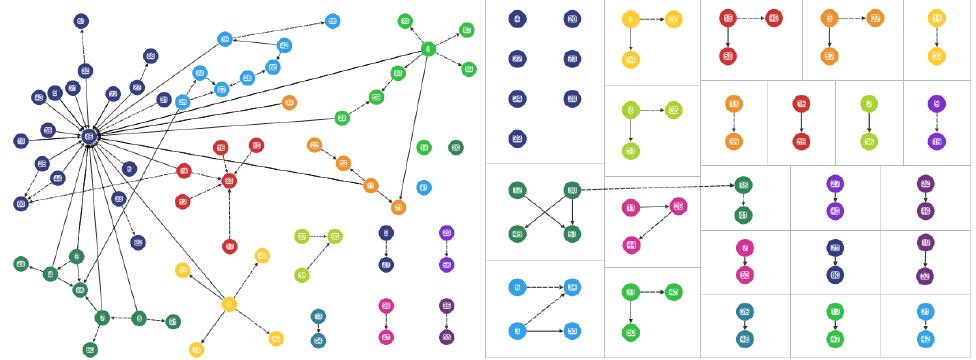
Figure 4. Clusters in the combined mothers’ health advice-seeking network (Q15, Q23). “Rural 1” left hand side and “Urban 1” right side. Coloured nodes denote the clusters, black ties denote health advice nominations and black dashed ties denote general advice nominations.